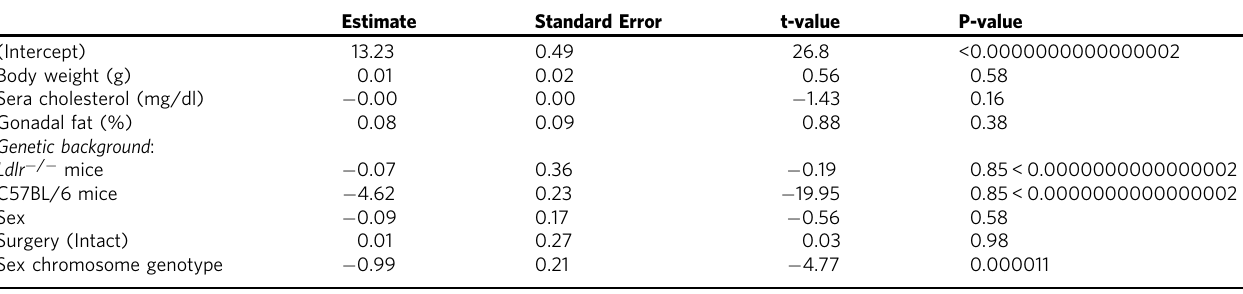
Livers of XX males and females have diverse gene expression . chromosome genotype) (Table 2). We included all mice in the analysis for which we had measurements on all variables. After Elevations in serum lipids of XX mice could result from altera- adjusting for all other variables, there were two explanatory tions in cholesterol and/or lipid homeostasis in liver, a major variables that were signi fi cant for the development of athero- organ for lipoprotein synthesis, secretion and clearance. To focus sclerosis, namely sex chromosome genotype and genetic back- on sex chromosome in fl uences on transcriptional pro fi les in the ground (Table 2). absence of sex hormones, livers from GDX mice were used. We NATURE COMMUNICATIONS| (2019) 10:2631